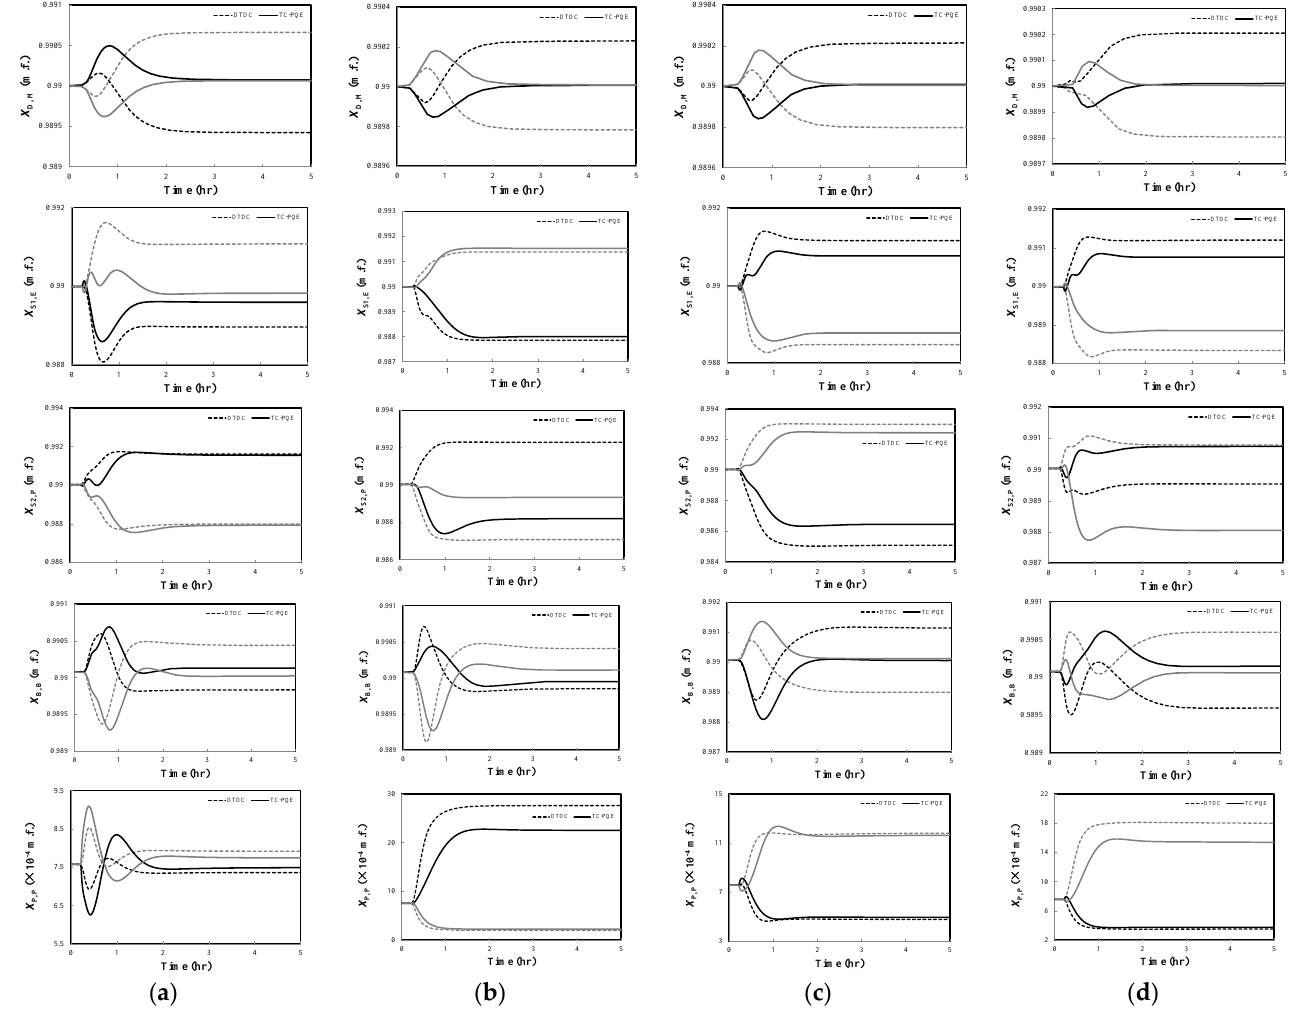
Figure 12. Variations of the product purities as maintained with the DTDC and TC-PQE schemes for ±20% variations in feed compositions (Example II): ( a ) M; ( b ) E; ( c ) P; ( d ) B. (Black line: positive disturbance; grey line: negative disturbance). Table 6. Steady-state deviations for ±20% variations in feed compositions of M, E, P, and B (Example II).